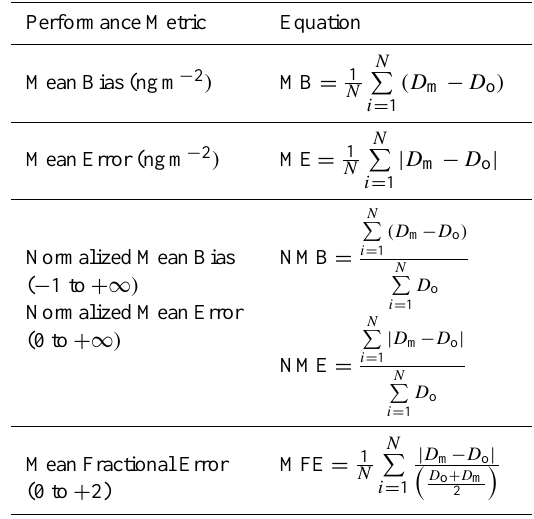
Table 1. Sigma-p layer definitions for 14-layer and 34-layer CMAQ simulations.